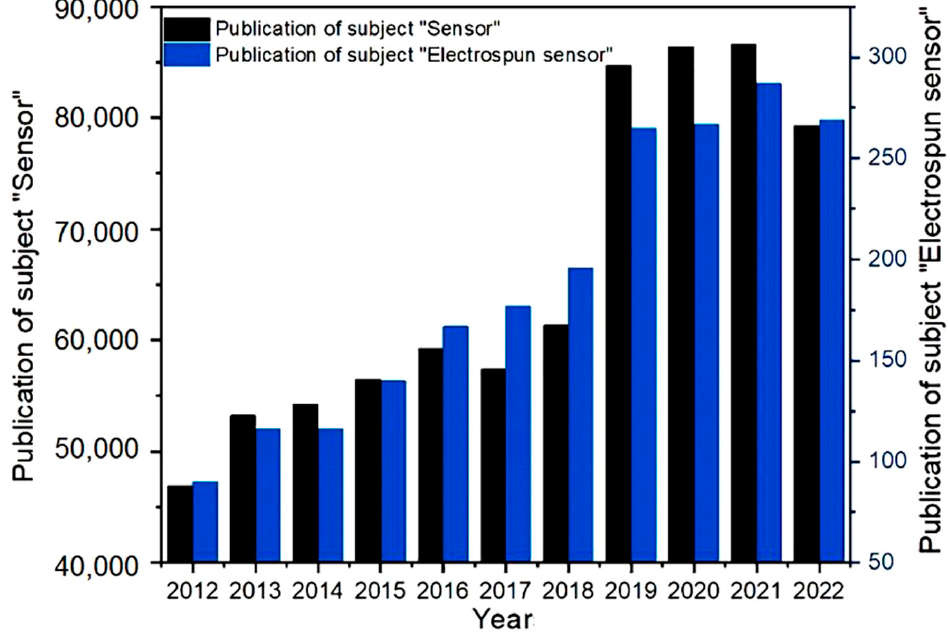
Figure 1. The literature search statistics using the themes “Sensor” and “electrospinning and electric spinning sensor” on the Web of Science platform.